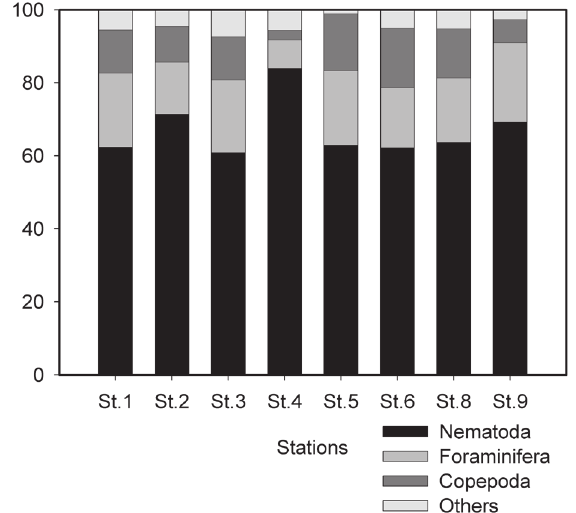
Fig . 2. – average contribution (%) of different groups to the total meiobenthos in the three study areas.